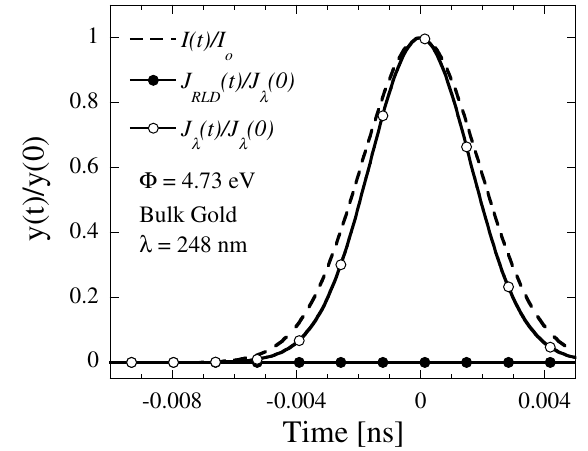
FIG. 14. Quantum efficiency for experimental parameters and its projection for higher laser power and surface coverage factors. Factors not explicitly listed are presumed the same as 2 : 55 MV = m , but also higher fields characteristic of Naval